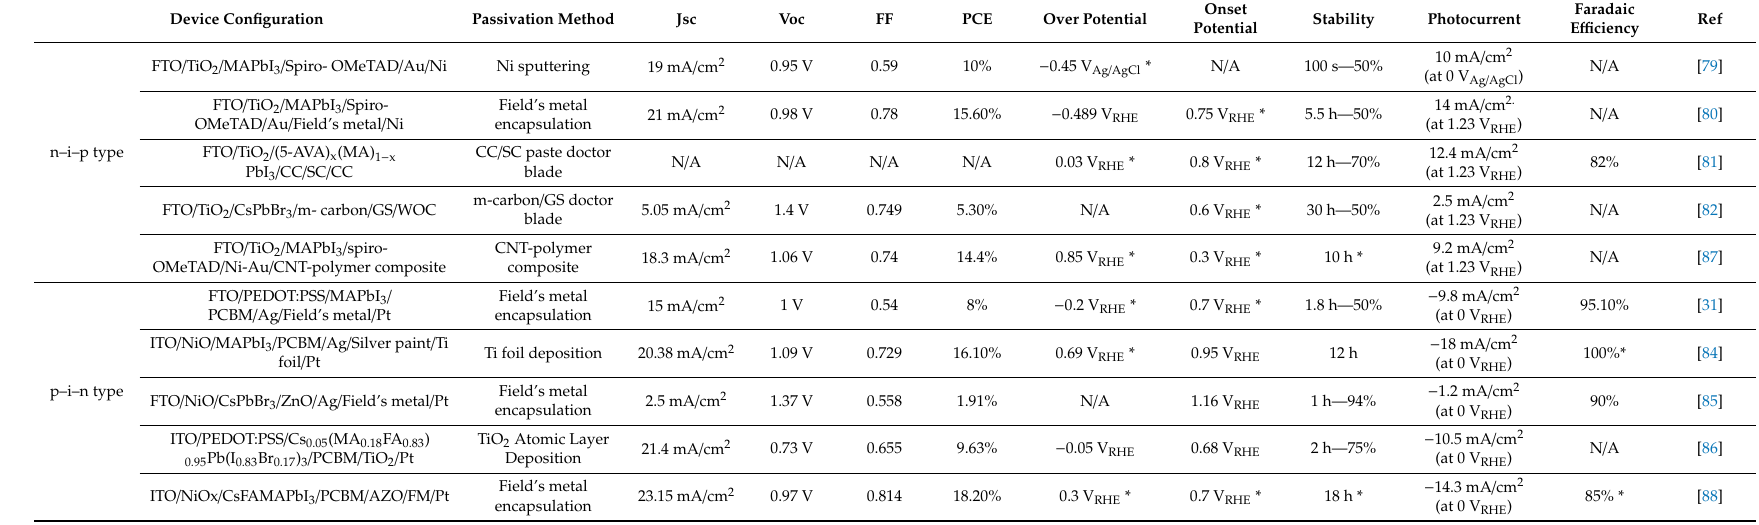
Table 1. Photoelectrochemical and photovoltaic performance of perovskite-based cells depending on charge transporting materials, perovskite materials, and cell configurations. (* Approximate